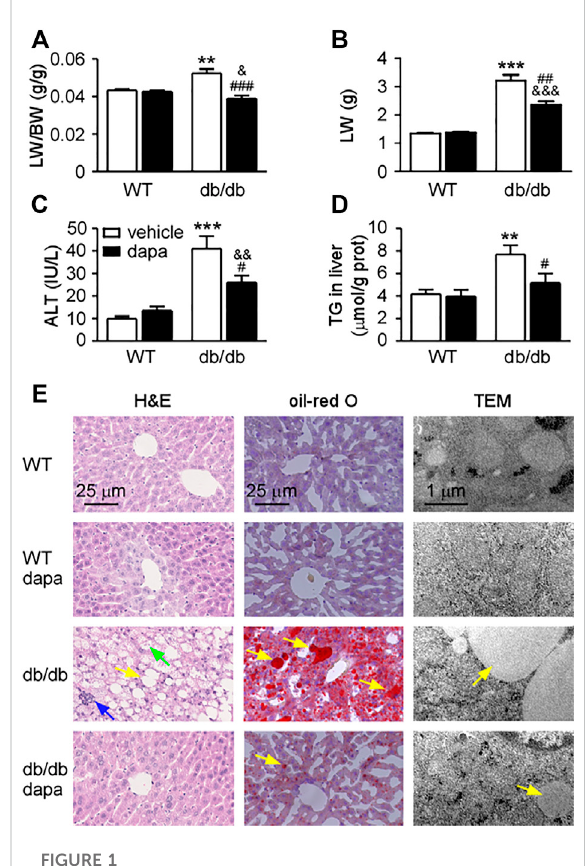
FIGURE 1 Dapagli fl ozin ameliorated hepatic damage in db/db mice. (A) The ratio of liver weight to body weight (LW/BW). (B) Liver weight (LW). (C) Blood alanine transaminase (ALT). (D) Triglyceride (TG) in livers. (E) Liver tissue images. Hematoxylin and eosin (H&E, up), oil-red O staining (middle), and transmission electron microscope (TEM, down). Yellow arrows represent steatosis, blue arrows represent lobular in fl ammation, and green arrows represent hepatocellularballooning. Mean ±SEM, n=6. * p < 0.05, ** p < 0.01, and *** p < 0.001 vs. wild-type (WT) mice. # p < 0.05, ## p < 0.01, and ### p < 0.001 vs. db/db mice. & p < 0.05, && p < 0.01, and &&& p < 0.001 vs. dapagli fl ozin-treated wild-type mice. One- way ANOVA, Bonferroni ’ s multiple comparison